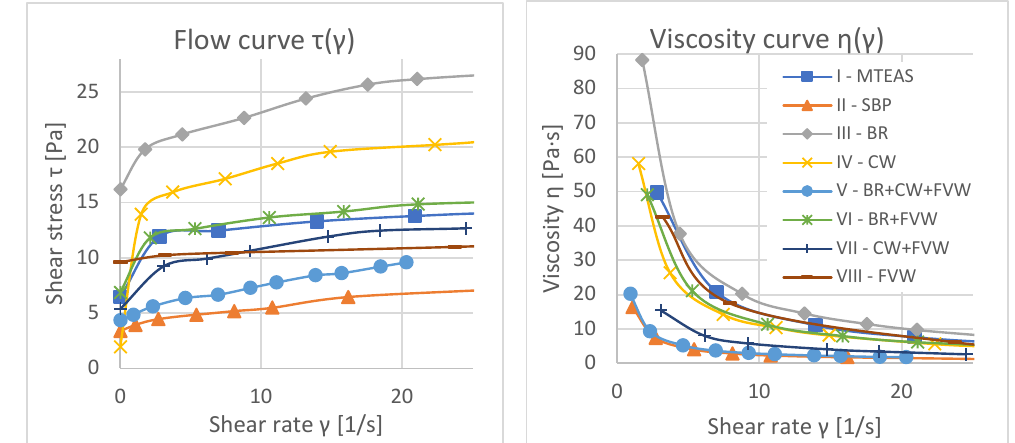
Figure 3. Flow and viscosity curves for all samples.